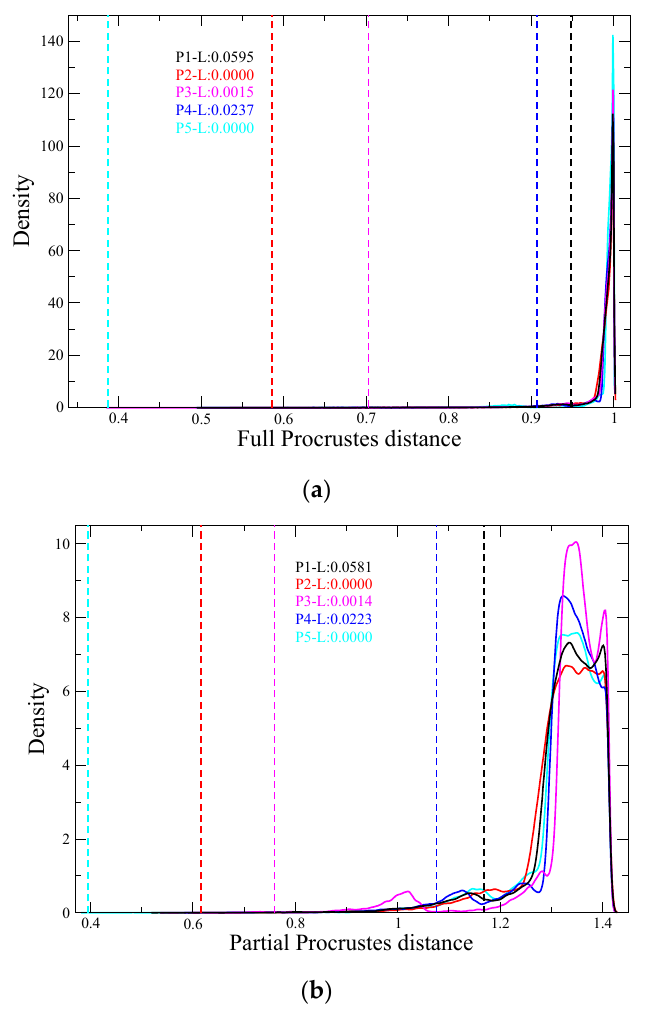
Figure 7. Randomness and permutation tests for validation of BA products via Procrustes distances. ( a ) Permutation test for Full Procrustes Distance and the variables P11, P22, P12, P21, sum of biomass, total BA, and number of fires. ( b ) Permutation test for Partial Procrustes Distance under the variables P11, P22, P12, P21, sum of biomass, total BA, and number of fires.